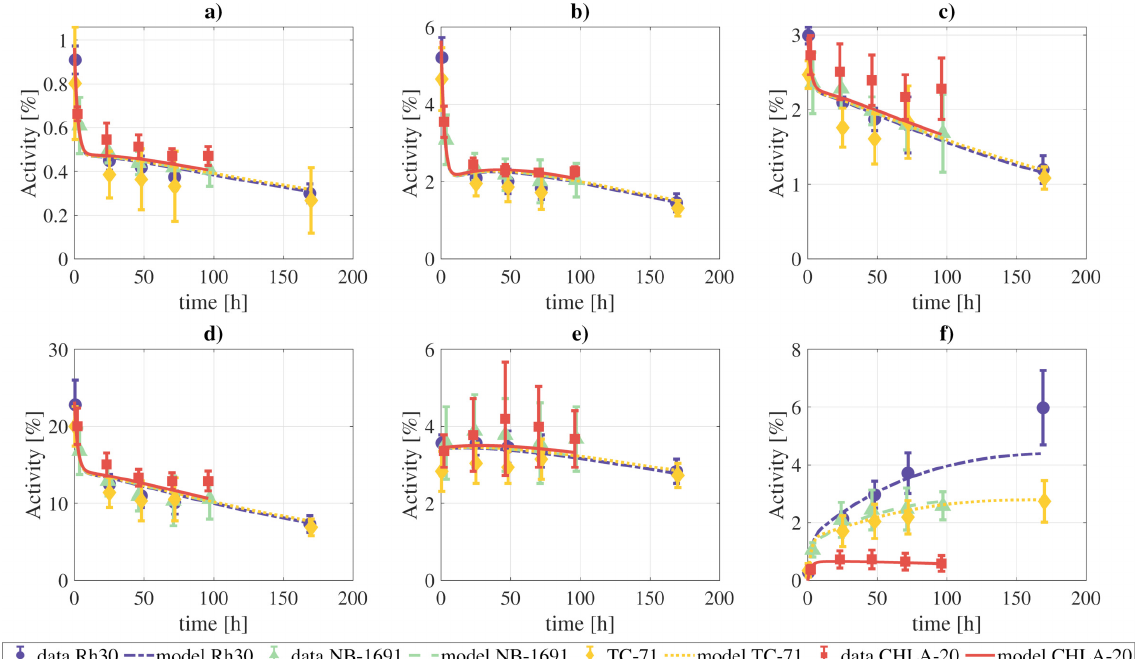
Figure 7. Fitting of the complete model to the combined tissue activities reported for xenografts in [1]: ( a ) lungs, ( b ) heart, ( c ) kidneys, ( d ) liver, ( e ) marrow, ( f ) tumor. The parameters which govern the tumor compartments were allowed to vary individually for each tumor cell line. The objective function reached a value of WRSS =